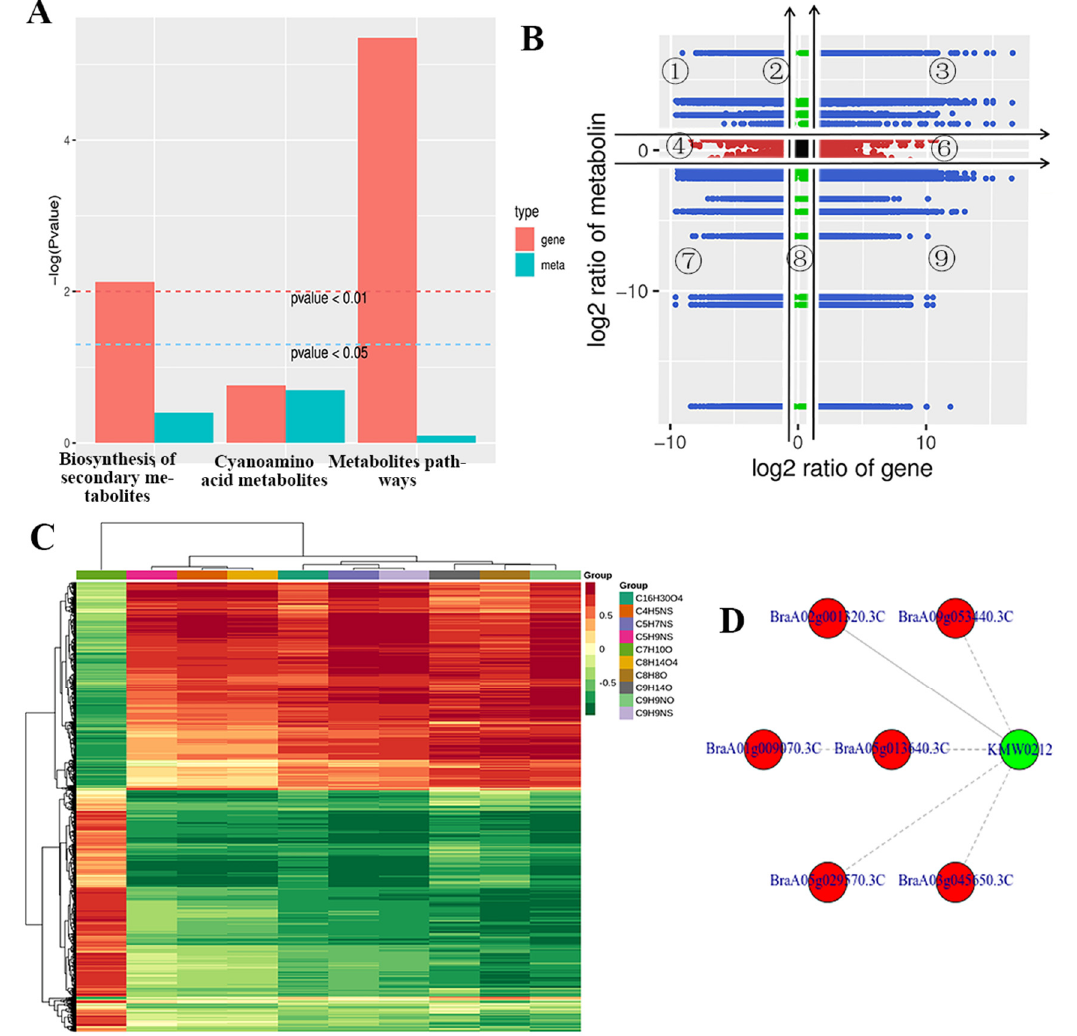
Figure 9. Integrated volatile metabolome and transcriptome analysis of volatile organic compound (VOC) accumulation in Brassica rapa . There were more differentially expressed genes than differen- tially expressed metabolites enriched in biosynthesis of secondary metabolites, cyanoamino acid metabolites, and metabolites pathways ( A ), Through Pearson’s correction coefficient (PCC) analysis for the different genes and metabolites, genes and metabolites had an inconsistent regulatory trend. Red dots indicate changes only at the metabolic level; Green dots indicate changes only at the gene level; Blue dots indicate changes at the metabolic level and gene levels. Black dots indicate both genes and metabolites were not differentially expressed ( B ), Heat map with Pearson’s correlation coefficient above 0.8 ( C ), Five pathways showed higher corrections after inoculation with TuMV. Green represents metabolites, red represents genes, solid lines represent positive correlations, and dotted lines represent negative correlations ( D ).